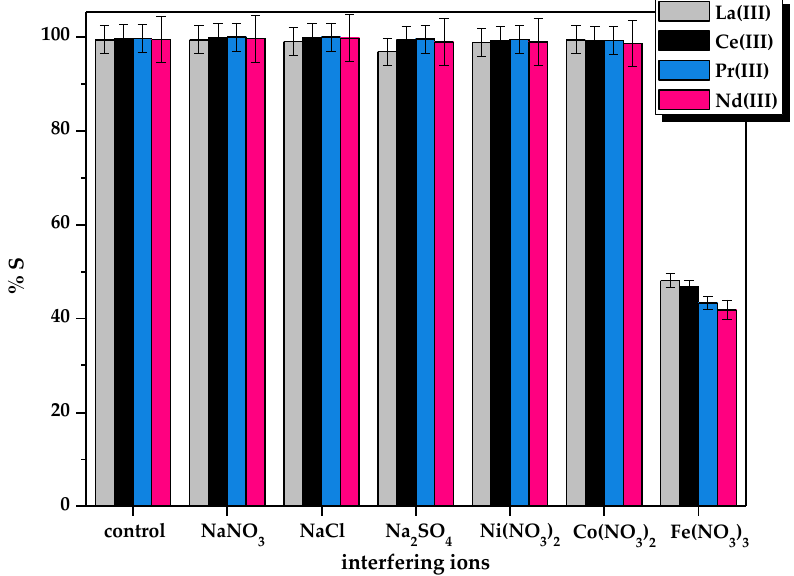
Figure 5. Effects of interfering ions on the La(III), Ce(III), Pr(III), and Nd(III) ions sorption using the ALG 5 L 1 composite (conditions: C 0 = 100 mg/dm 3 , m = 0.05 g, V = 20 cm 3 , t = 480 min, T = 293 K).